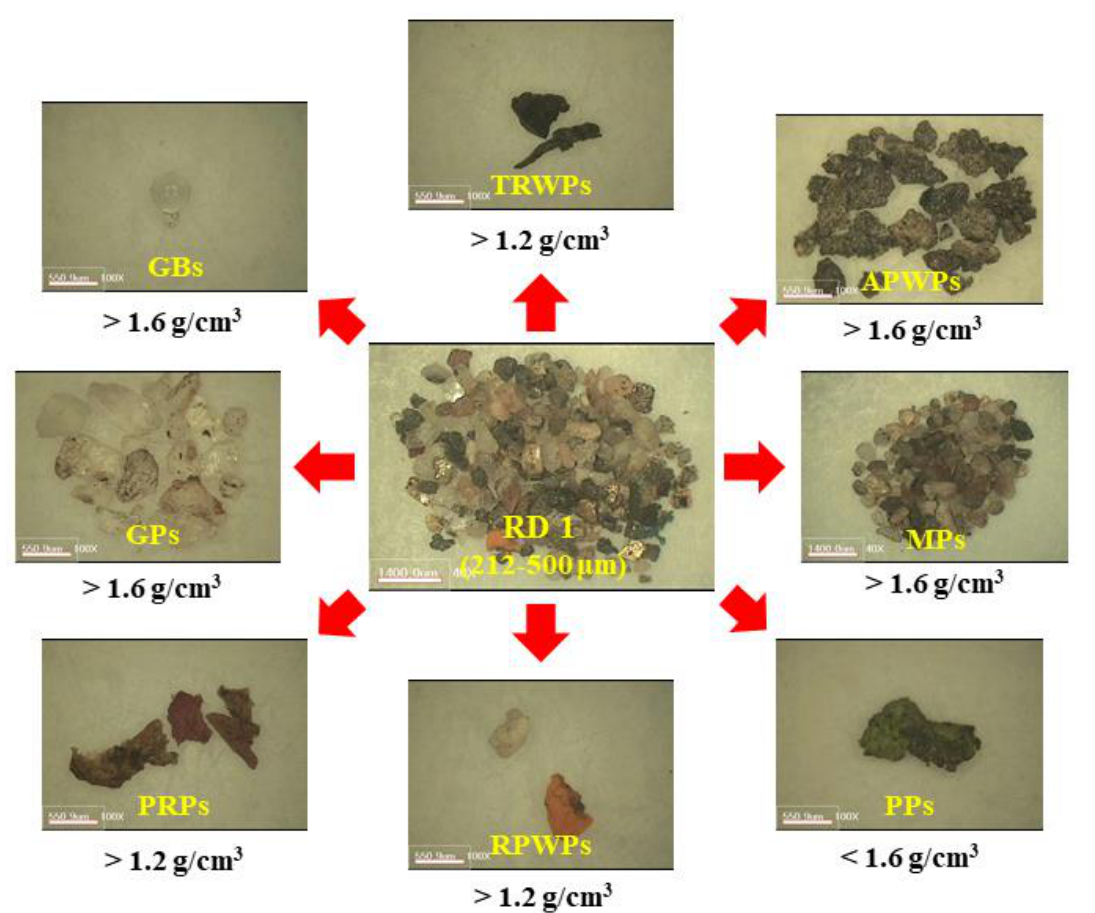
Figure 1. Density ranges of various particles in the RD1 sample. The scale bar of the center image is 1400 µ m, and those of the others are 551 µ m.